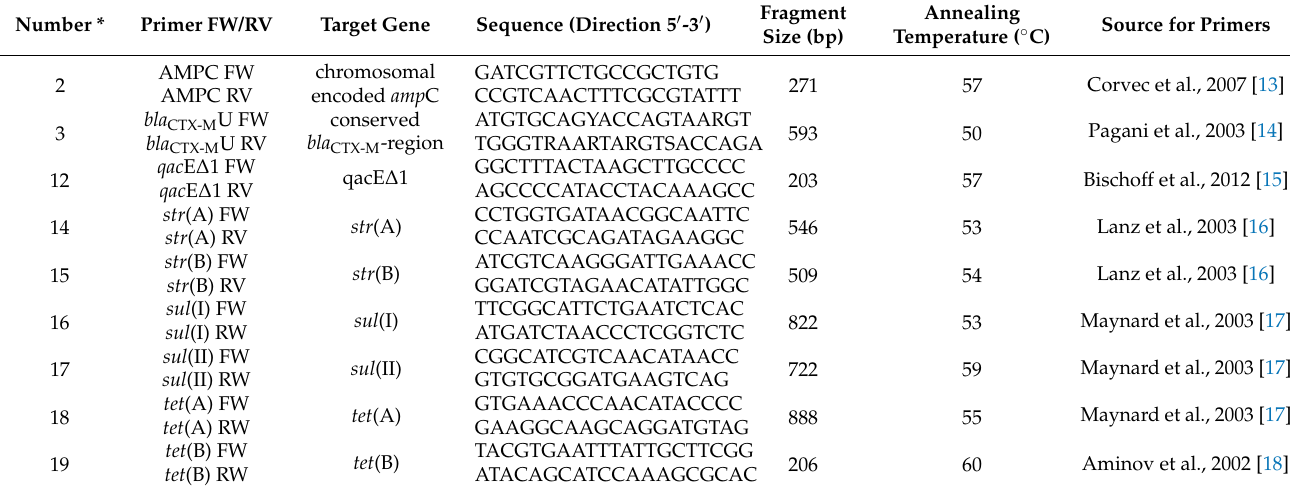
Table 3. Target genes, fragment size, and annealing temperature of primers used for qualitative resistance gene detection.